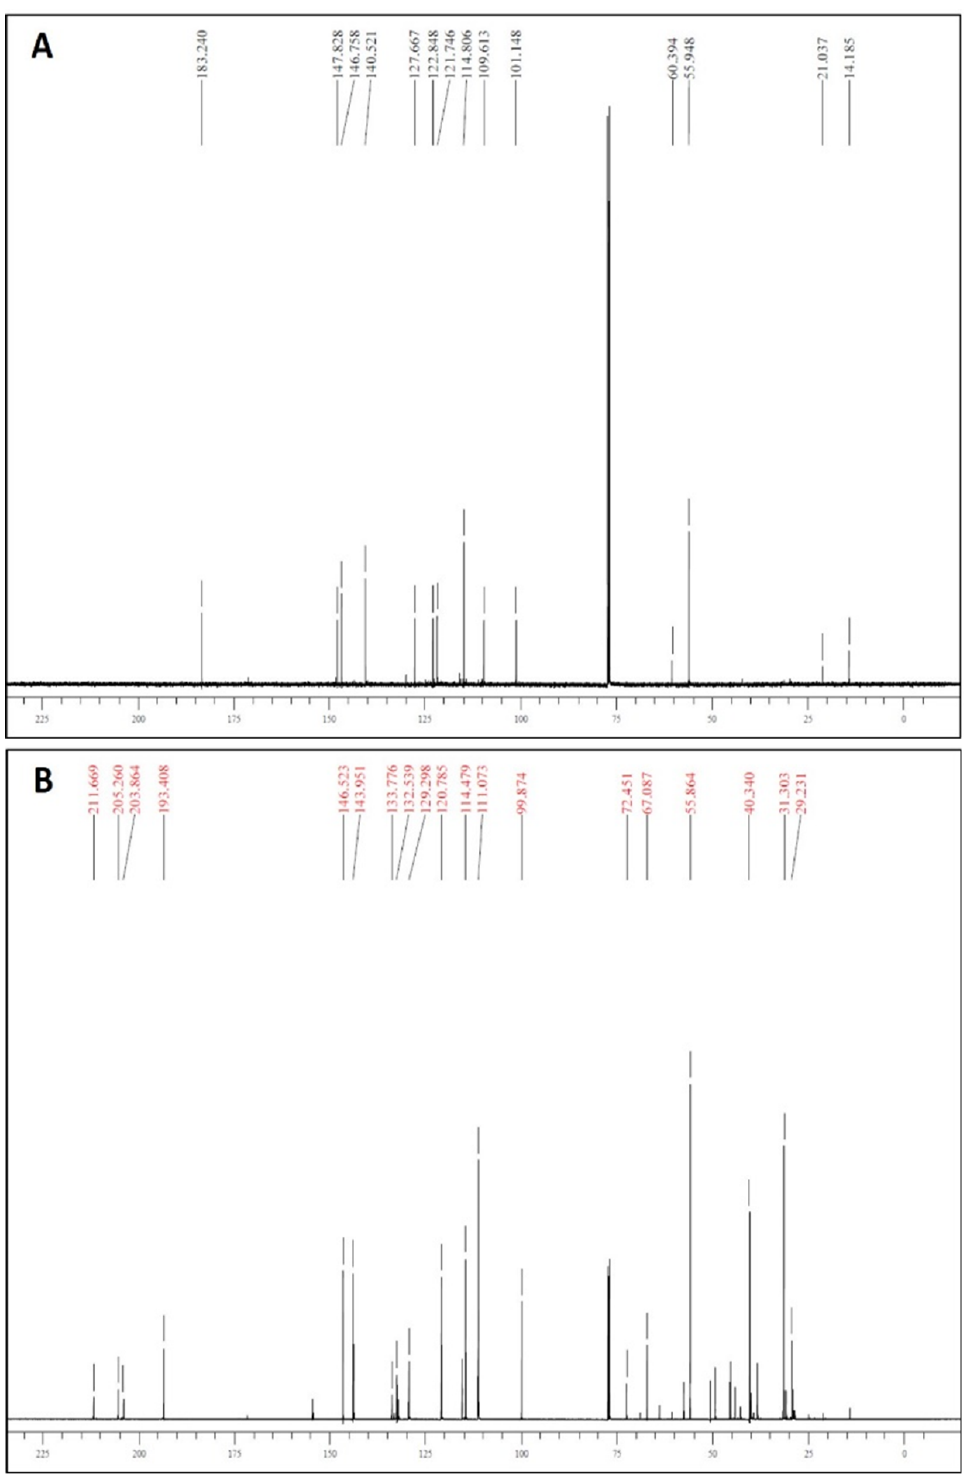
Figure 5. 13 C-NMR spectra of CM (panel A ) and THCM (panel B ). The conversion of CM was >90% and after the workup operations THCM was used as it is for the synthesis of the polymer (THCM-PC).